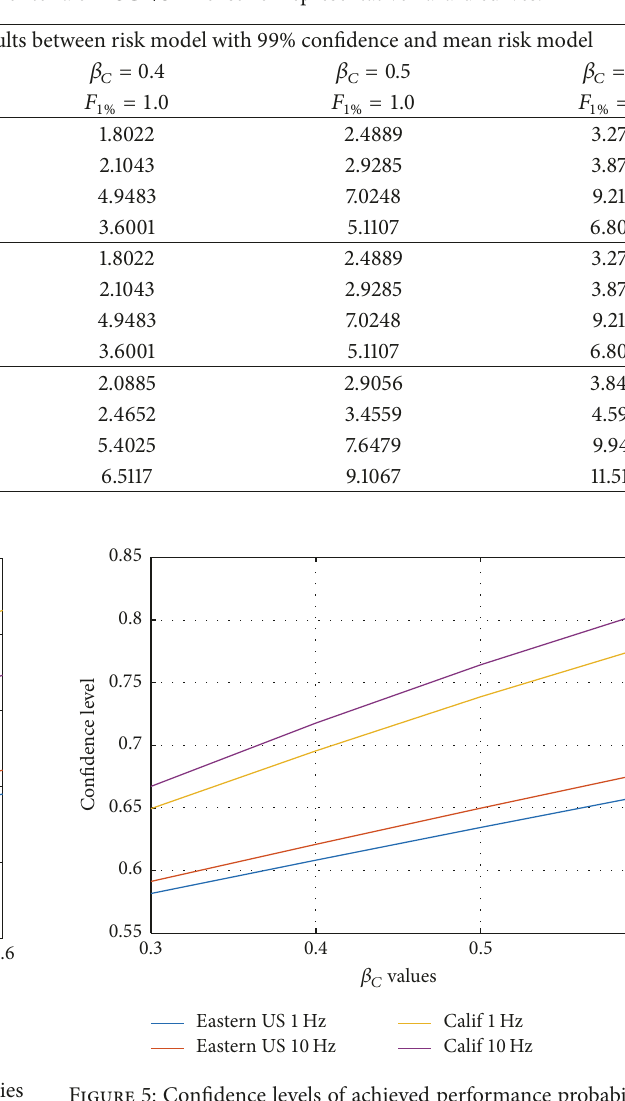
Figure 5: Confidence levels of achieved performance probabilities for SDC 5 based on both the first and second criteria of ASCE/SEI 43-05 for representative hazard